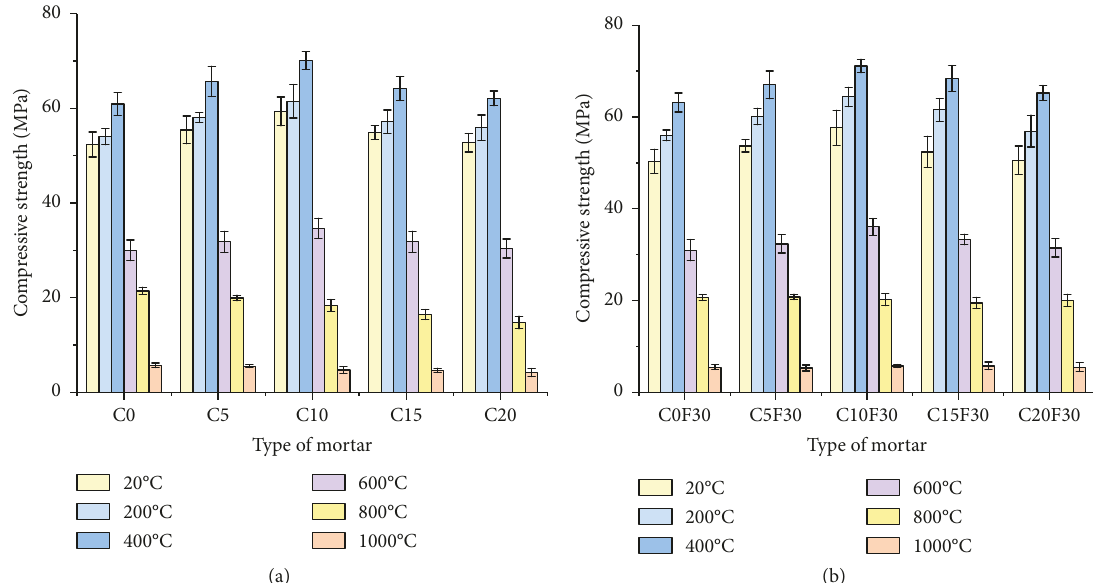
Figure 3: Compressive strength of (a) CaCO 3 whisker-based specimens and (b) CaCO 3 whisker-based fly ash specimens before and after exposure to various